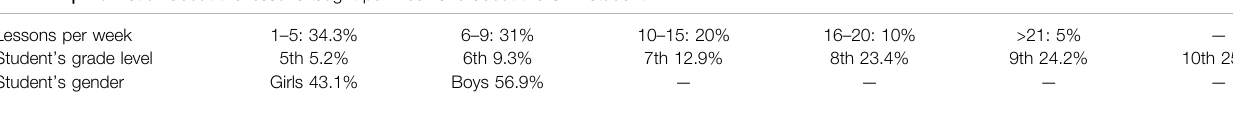
TABLE 1 | Information about the lessons taught per week and about the SAP student. Lessons per